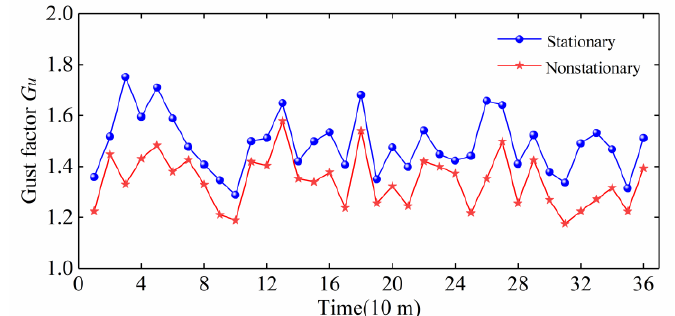
Figure 8. Comparison of the gust factors of Typhoon Lekima with a 10-min duration.